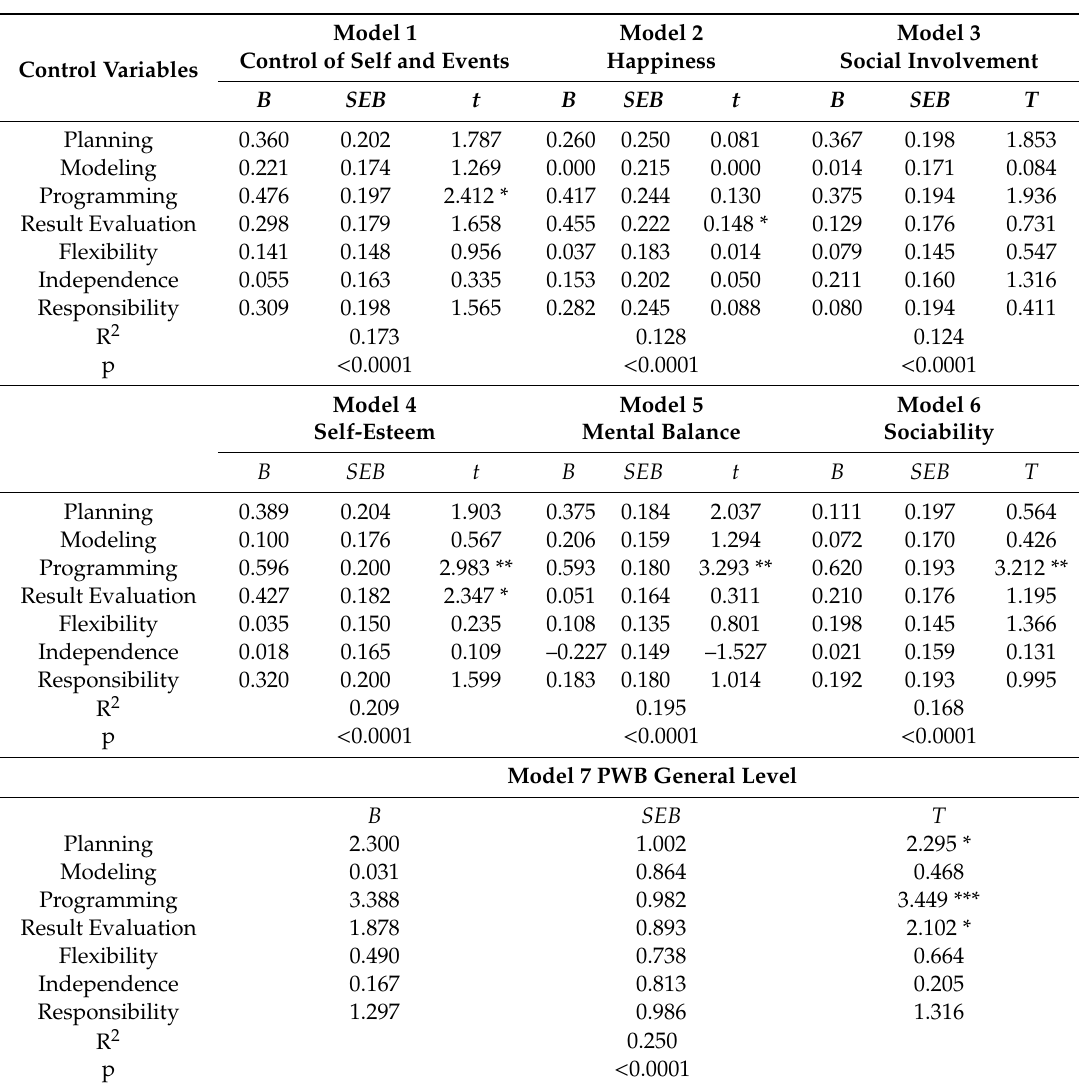
Table 2. Summary of a lagged regression analysis for the variables predicting psychological well-being (N =